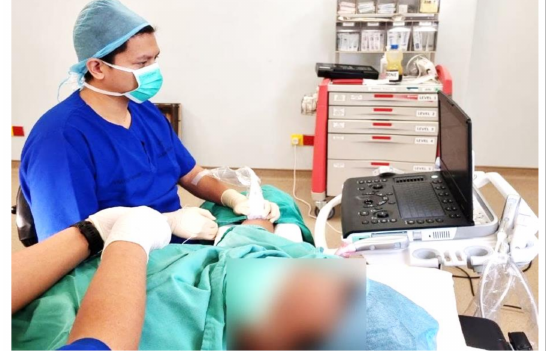
Figure 3. Neutral position while performing a mid-forearm median nerve block. The operator is in a seated balanced position using a supported chair with the ultrasound monitor in front. The two most common improper postures are arm abduction, defined as an angle greater than 30 ◦ between the torso and the upper extremity, and overreaching, which requires the operator to use the shoulder muscles (Figure 4). This can be avoided by moving the patient closer to the operator [29].